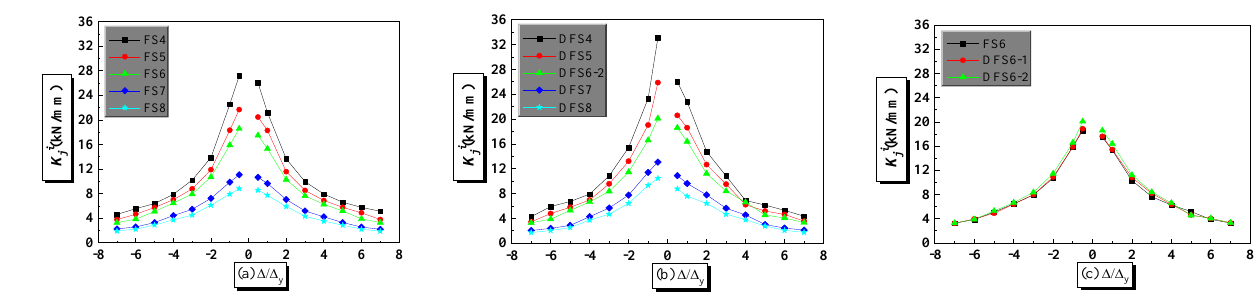
Figure 12. Stiffness degradation curves of PPSRC beam–column joints: ( a ) models FS4, FS5, FS6, FS7 and FS8; ( b ) models DFS4, DFS5, DFS6-2, DFS7 and DFS8; ( c ) models FS6, DFS6-1 and DFS6-2.